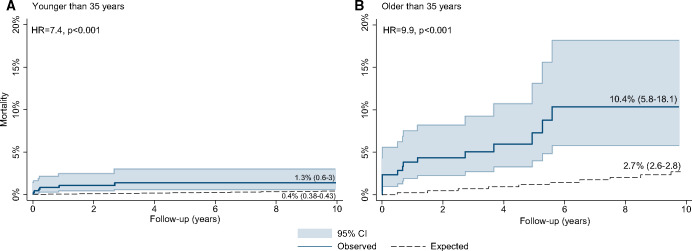
Comparison between Kaplan–Meier survival estimates of repaired tetralogy of Fallot patients undergoing pulmonary valve replacement (PVR) under 35 years of age (A) and between 35 and 50 years of age (B) and simulated patients based on ONS matched population. Both the relative risk increase (HR 9.9 vs 7.4) and the absolute mortality excess to the general population (7.7% vs 0.9%) were higher in those undergoing PVR between 35 and 50 years of age. CI: confidence interval; HR: hazard ratio; ONS: Office for National Statistics.